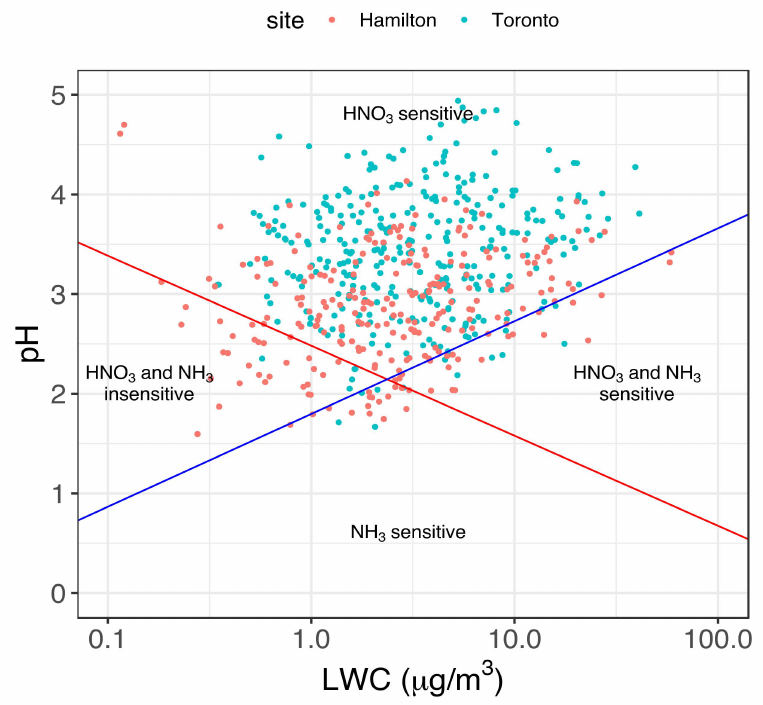
Figure 4. Domains of aerosol sensitivity to ammonia and nitrate levels calculated for the average temperature of the respective dataset. The values for Hamilton are shown in red, and those for Toronto are shown in light blue. The red and blue diagonal lines indicate the “characteristic pH” for HNO 3 and NH 3 , respectively, estimated using the average temperature (11 ◦ C) and RH (68%) for the two combined